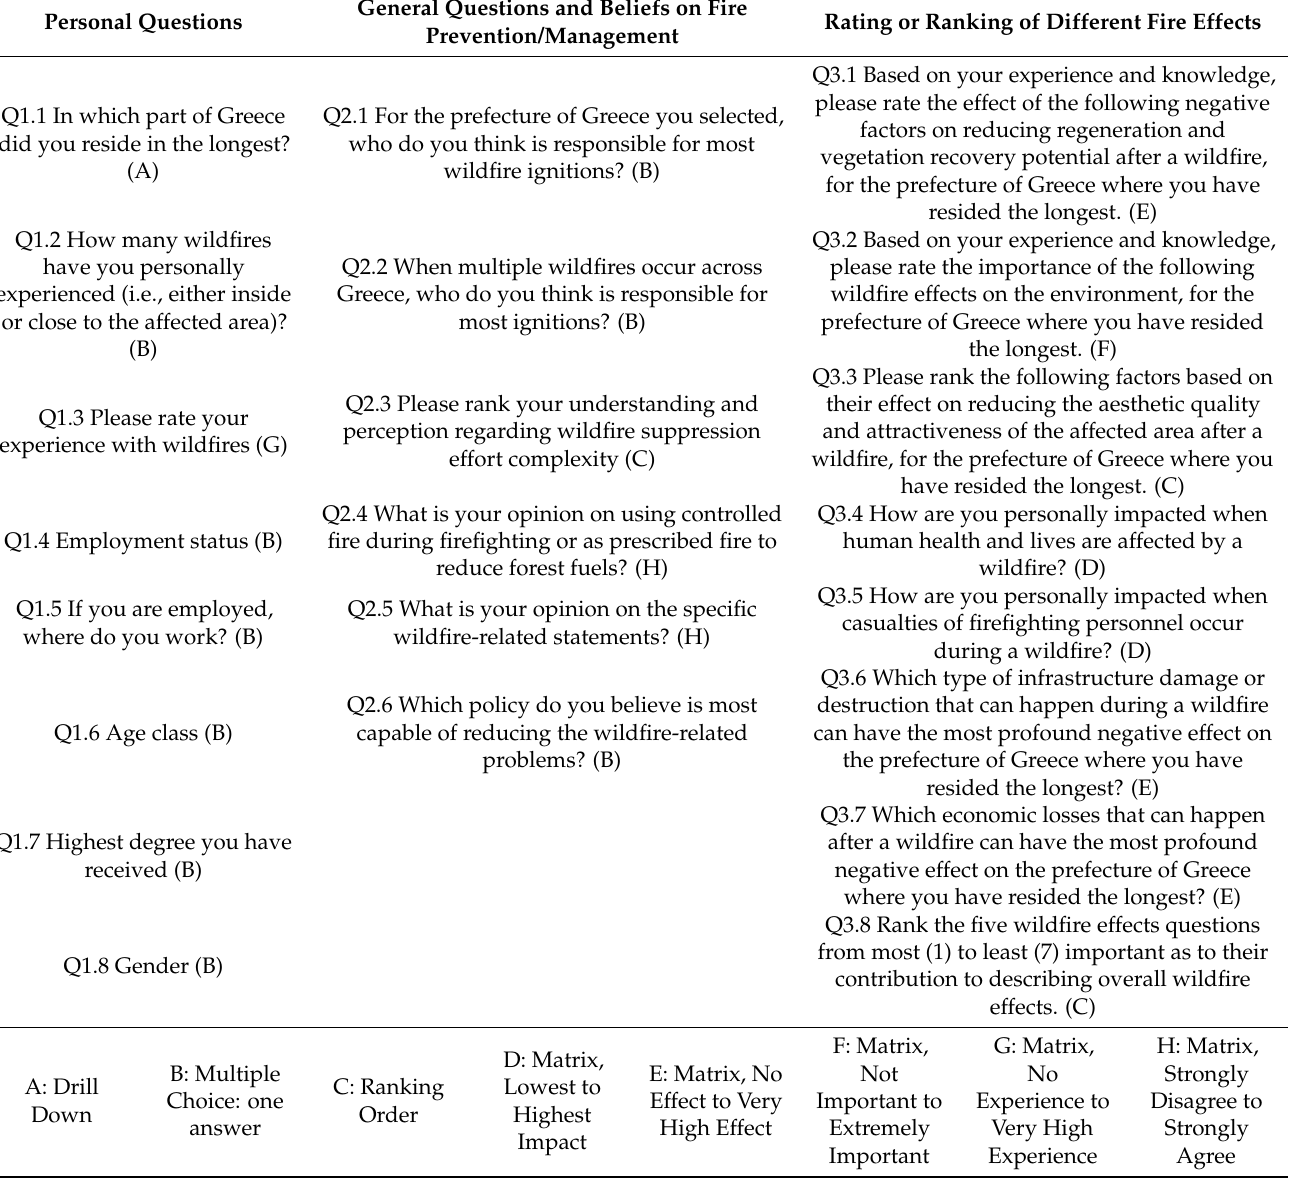
Table 1. Survey questions, each assigned to one of three groups. The letter in parentheses at the end of the question denotes the question type and the available range of responses referenced in the bottom